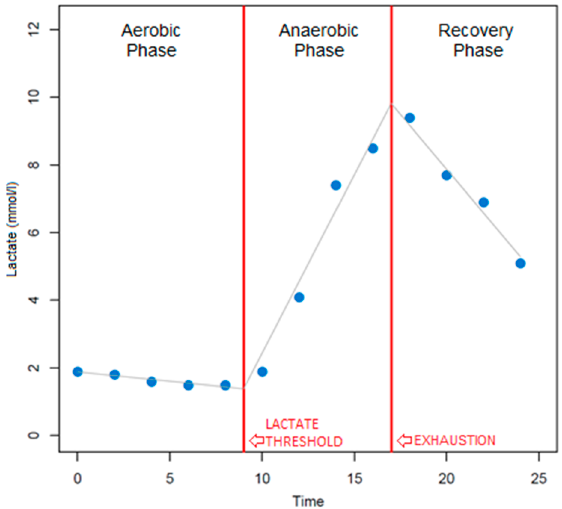
Figure 3. Change-point segmentation of lactate accumulation during a 25 min running session.